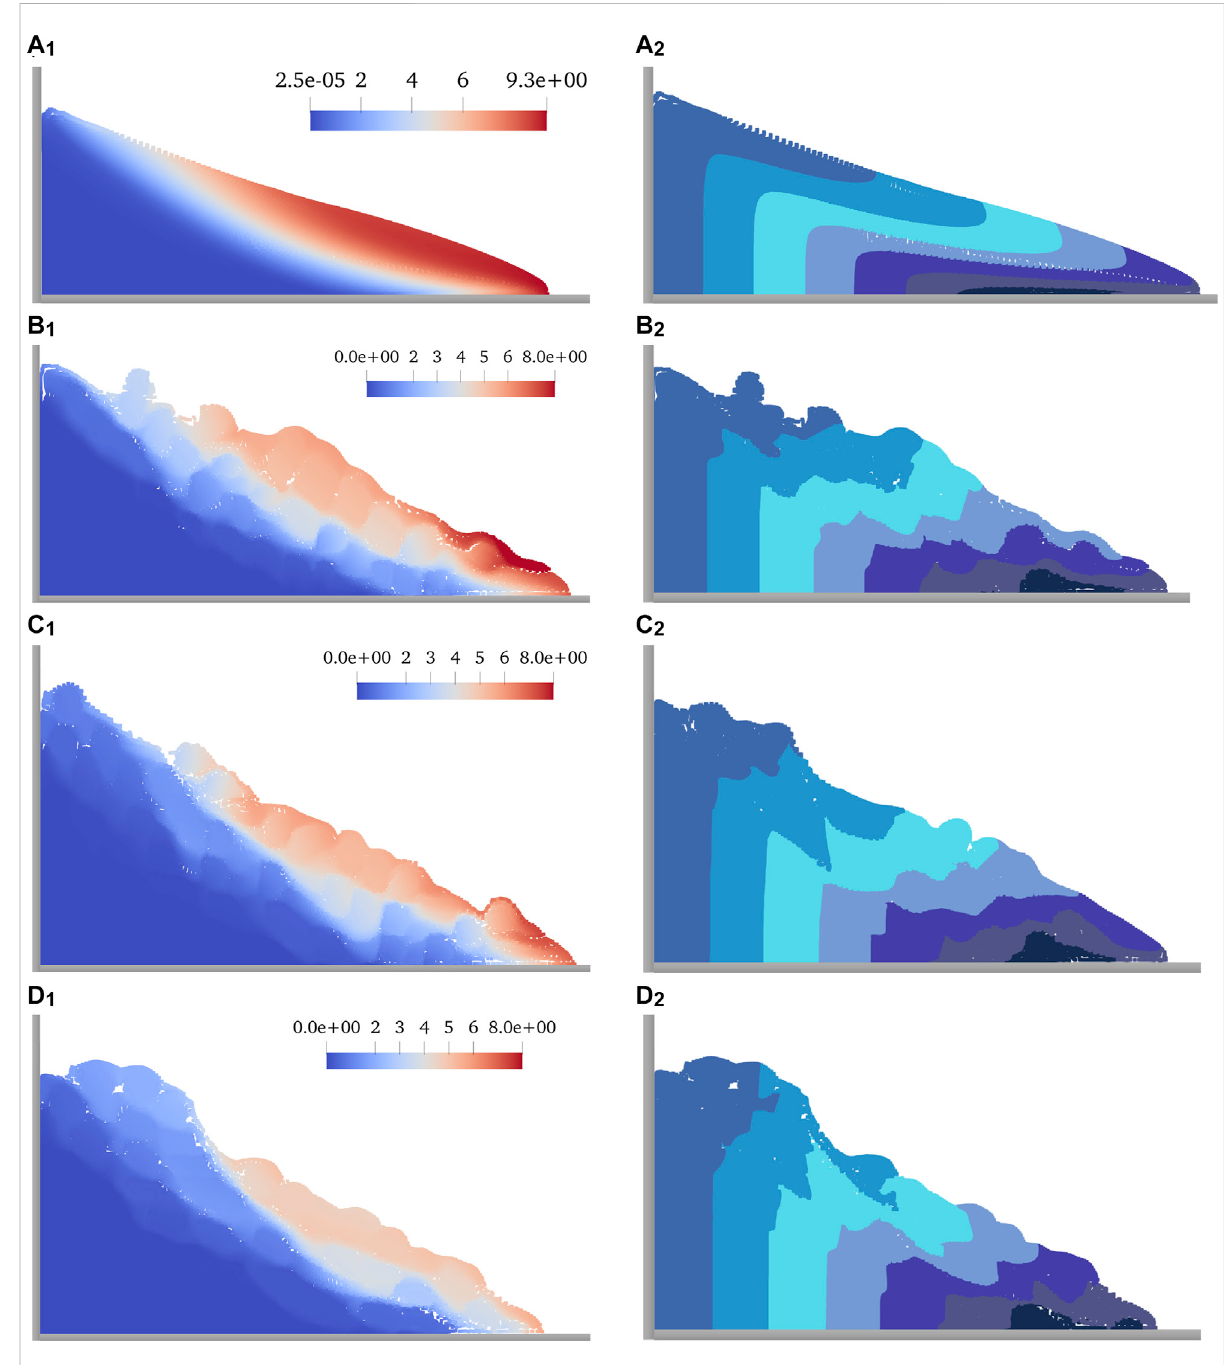
FIGURE 7 Displacementdistributionand fi nalcon fi guration after the landslide. (A 1 ) Displacement (m)cloud map ofthe homogeneoussoil slope at10.0 s. (A 2 ) Finalcon fi gurationofthehomogeneoussoilslopeat10.0 s. (B 1 ) Displacement(m)cloudmapoftheSRMslope(arbitraryshapesstones)at10.0 s. (B 2 ) Final con fi guration of the SRM slope (arbitrary shapes stones) at 10.0 s. (C 1 ) Displacement (m) cloud map of the SRM slope (round stones)